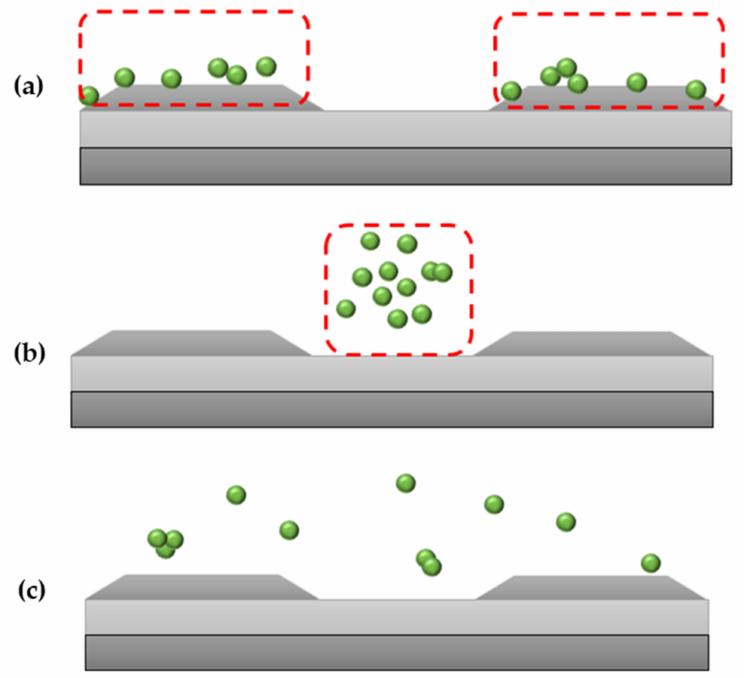
Figure 3. ( a ) pDEP or positive-DEP where particles are seen to be attracted to the edge of the electrodes. Particles move to the area with a higher field gradient, ( b ) nDEP or negative-DEP, where particles are seen repelled towards the center of the electrodes. Particles move away from the area with a high field gradient, ( c ) f xo also known as crossover frequency, where particles can be seen dispersed around the